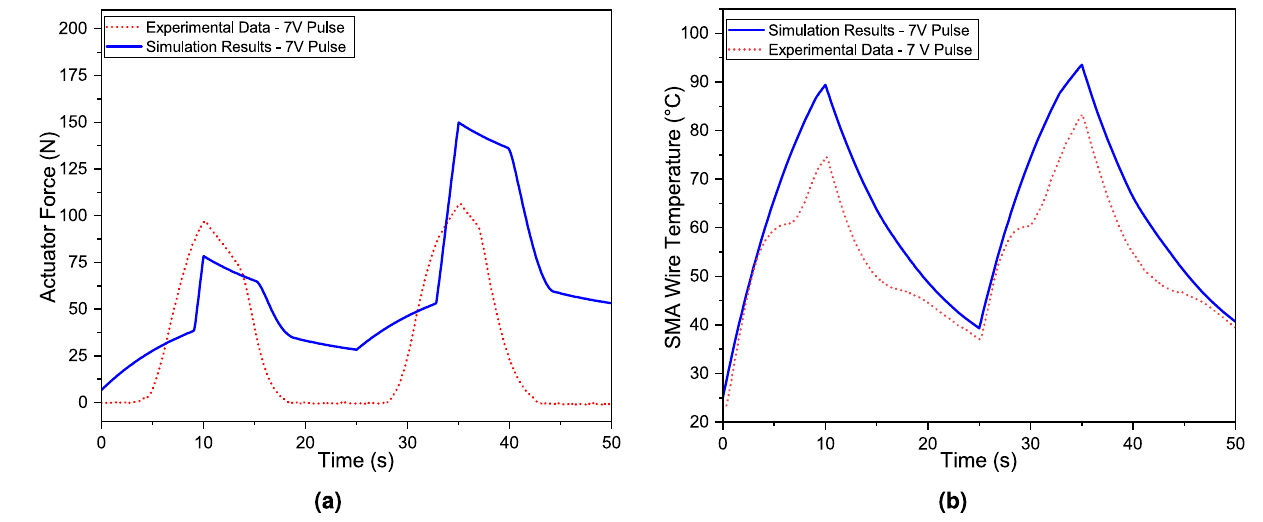
Figure 5. The comparison of the actuation parameters is obtained through experiments and analytical computations. The wires were subjected for 10 s with a 7V input pulse and then allowed to cool for 15 s (cooling phase) for two cycles. The pennation angle was set at 40 ◦ , and the initial length of the SMA wire in each unipennate branch was set at 83 mm. ( a ) The actuation force was measured using a load cell ( b ) Temperature of the wires were monitored using thermal IR camera.